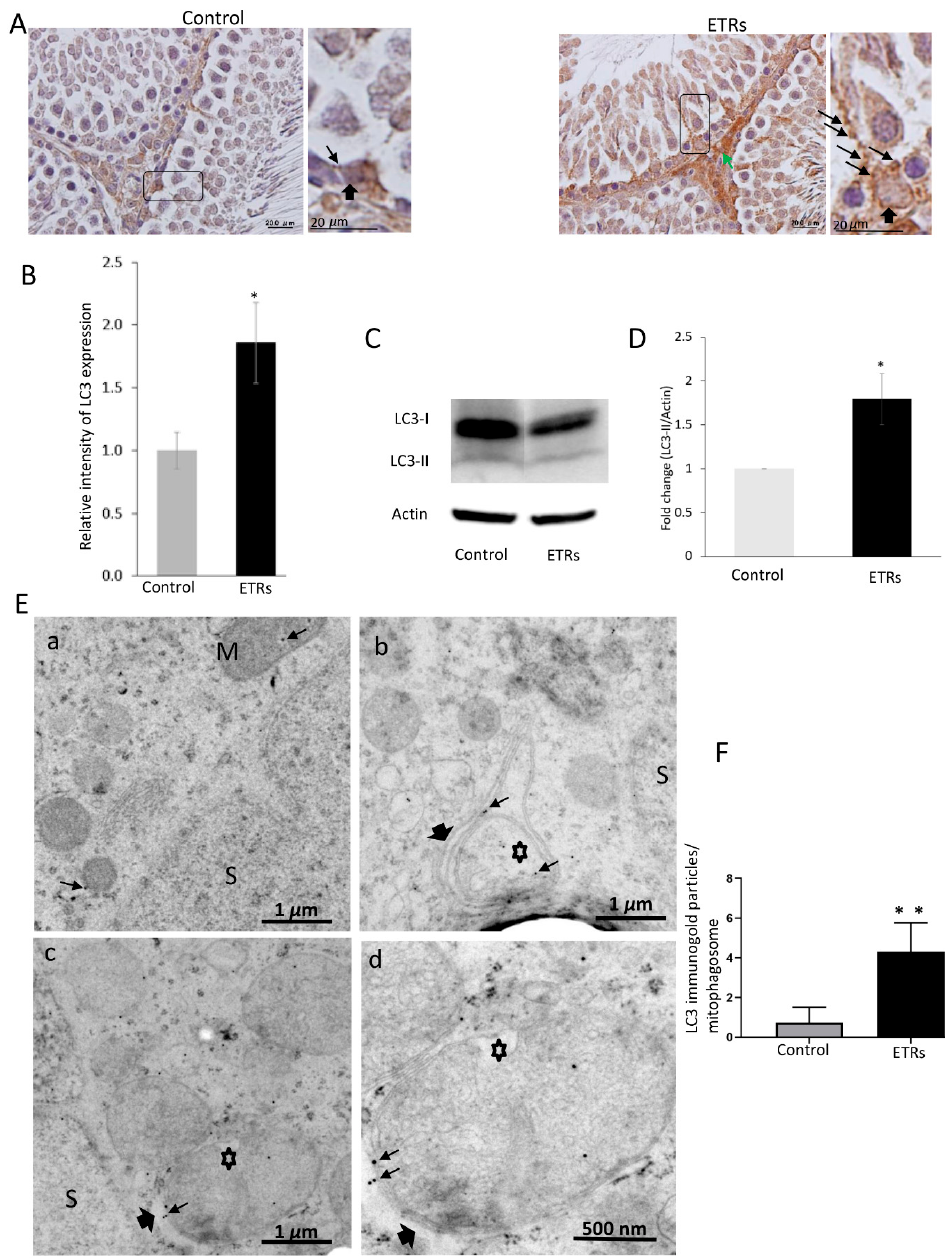
Figure 2. Enhanced light chain3 (LC3)-II expression in ETR SCs with specific localization to mitophagosomes ( A ) immunohistochemistry (IHC) of LC3. The framed areas are magnified in the insets on the right. LC3-II puncta are marked by long thin arrows, while short thick arrows indicate SCs nuclei. The green arrow marks expression in interstitial cells. ( B ) Quantification of LC3 expression in control and ETR SCs. ( C ) Western blot of LC3. The relative expression level of the protein is normalized to actin and expressed as a fold of the control ( n = 3) (this normalization applies to blots of other proteins shown below.) ( D ) Histogram showing significant increase of LC3-II in ETRs compared to the control. P < 0.05 ( t -test). ( E ) LC3 immunogold labeling in the control ( a ) and ETR SCs ( b – d ). Thin arrows indicate LC3 immunogold particles, while thick arrows mark autophagosomal membranes sequestering damaged mitochondria (asterisks) forming mitophagosomes. ( F ) Histogram demonstrating significant increase in the number of LC3-II immunogold particles in mitophagosomes of ETRs SCs compared to the control group. P < 0.01 ( t -test). M: normal mitochondria; S: SC